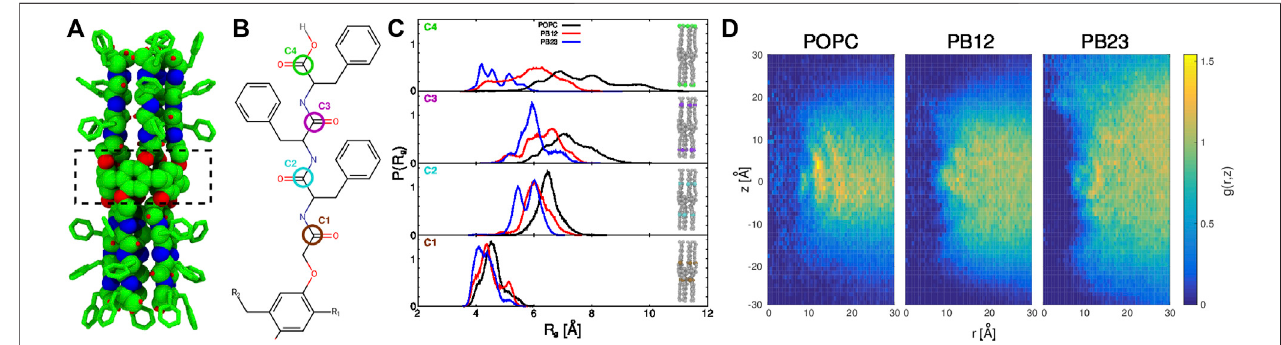
FIGURE 1 | (A) The structure of the PAP channel is shown in a space- fi lling representation (green, carbon atoms; blue, nitrogen atoms; and red, oxygen atoms). The hydrogen atoms are omitted for enhanced visualization of the structure. A dotted rectangle marks the central pillar(5)arene ring. (B) The chemical structure of a peptidearm ofPAPisshown with thecarbonyl carbon positions (C1, C2,C3,and C4) colored andlabeled. (C) The distributions ofthe radius ofgyration, R g , ofcarbonyl carbon atoms are shown for each membrane. (D) For each of the three types of membranes, shown are the two-dimensional maps of the radial and axial distributionfunction, g ( r , z ) (cid:2) N ρ ,where N istheaveragenumber ofcarbon atoms ineach bin, ρ isthebulk number density ofthehydrophobic block, dV isthevolumeof dV each bin de fi ned as dV (cid:2) π [( r + dr ) 2 − r 2 ] dz with dr and dz as the bin-widths along the r and z directions. The z -axis is aligned along the length of the channel and passes through the center of the pillar[5]arene ring of